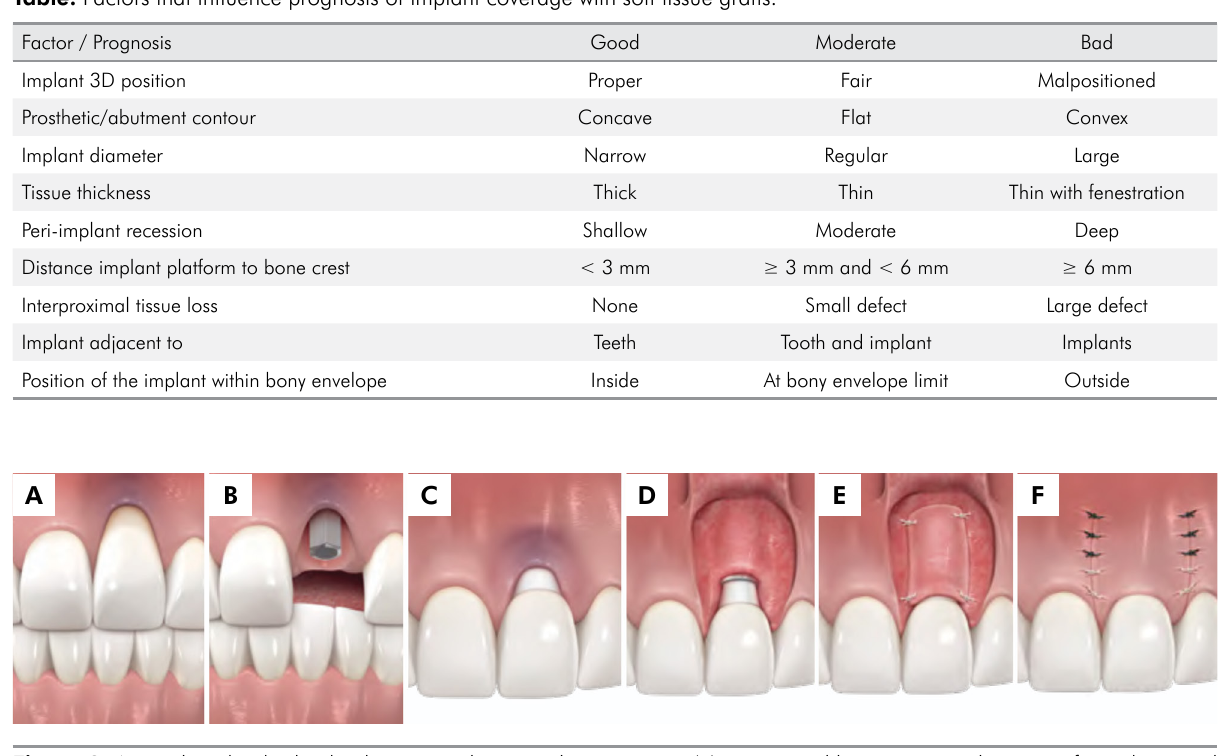
Figure 2. An implant that had a thin biotype and peri-implant recession (a) was treated by using a combination of prosthetic and surgical procedures. The implant crown and metal abutment (b) were removed, and an impression of the implant was performed to create a new zirconia abutment with a concave contour, in which the finishing line was placed at the level of the soft tissue margin of the contralateral tooth (c). Two vertical incisions were performed to create a full/split thickness flap (d). A thick connective tissue was sutured at the level of the abutment finishing line (e), and the flap was positioned coronally